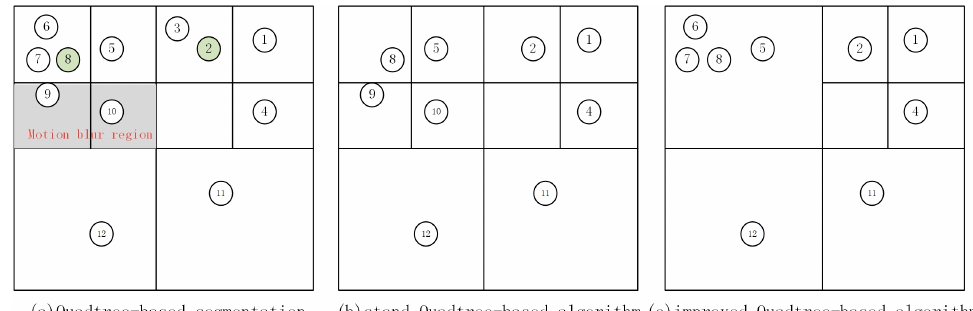
Figure 2. A schematic diagram of the quadtree-based algorithm. The circles denote the feature points. The grey area in ( a ) is the motion blur region, and the green circles represent the features with the highest Harris response values in their nodes. The desired features in ( b ) and ( c ) are set as 9.